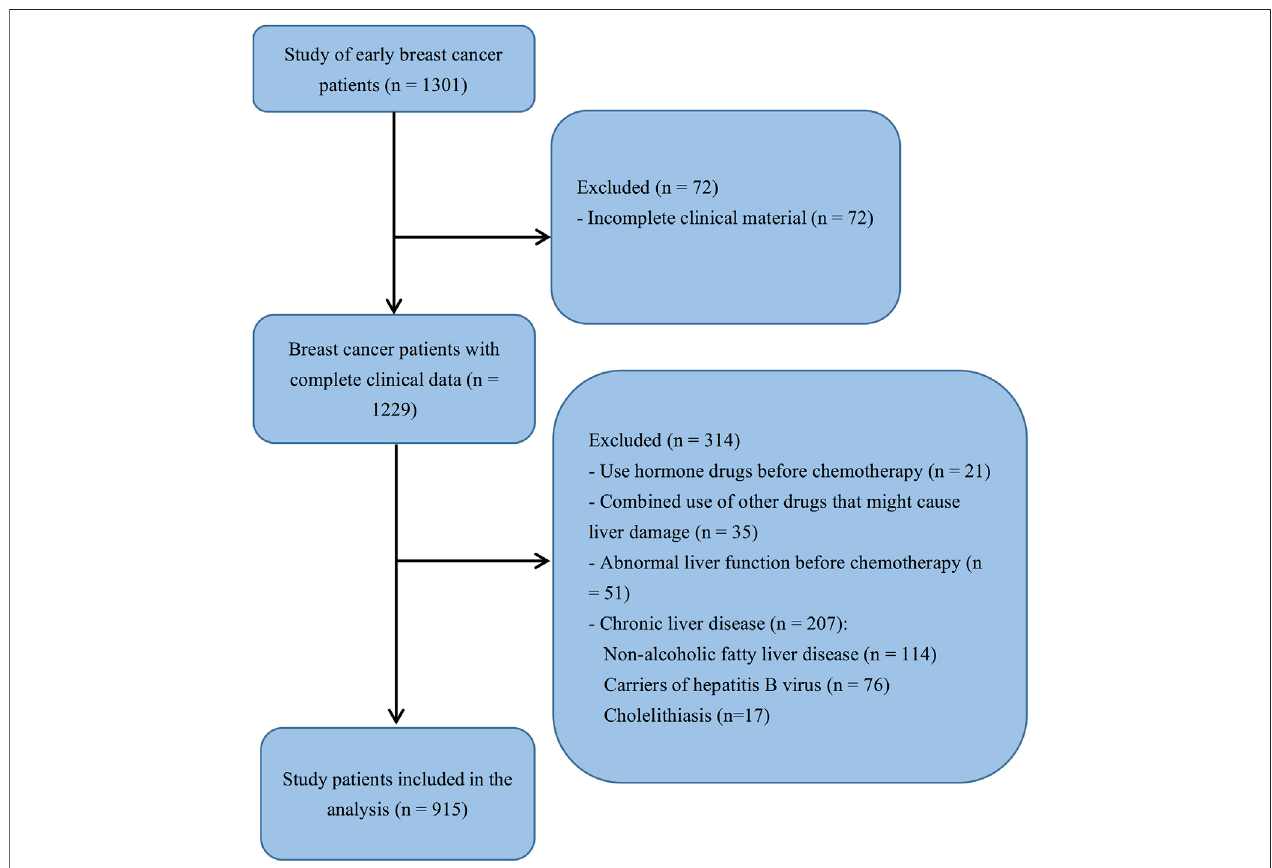
FIGURE1 | Flowchart ofstudy participant selection. The analysisincludedall patients withcomplete clinical data(n (cid:1) 1,229). After exclusions, the fi nal sample size was 915 patients.